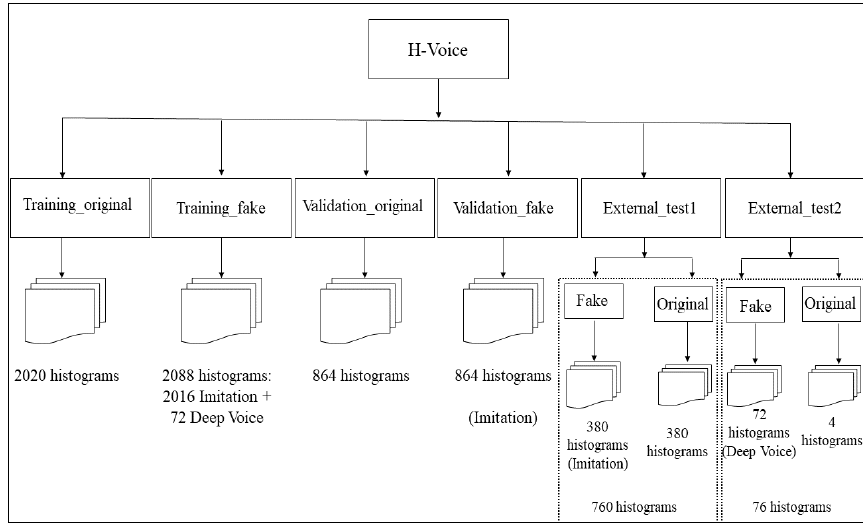
Figure 4 . The Structure of the H-Voice Dataset . Figure 4. The Structure of the H-Voice